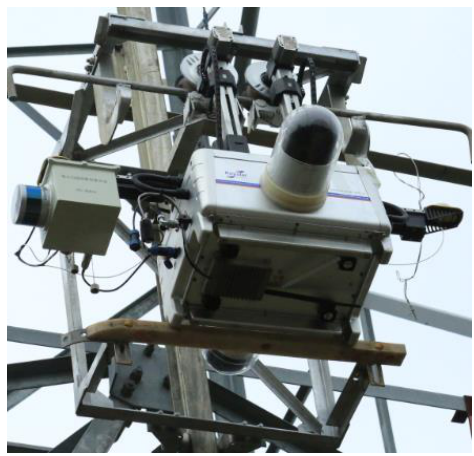
Figure 19. The automatic up-line device.